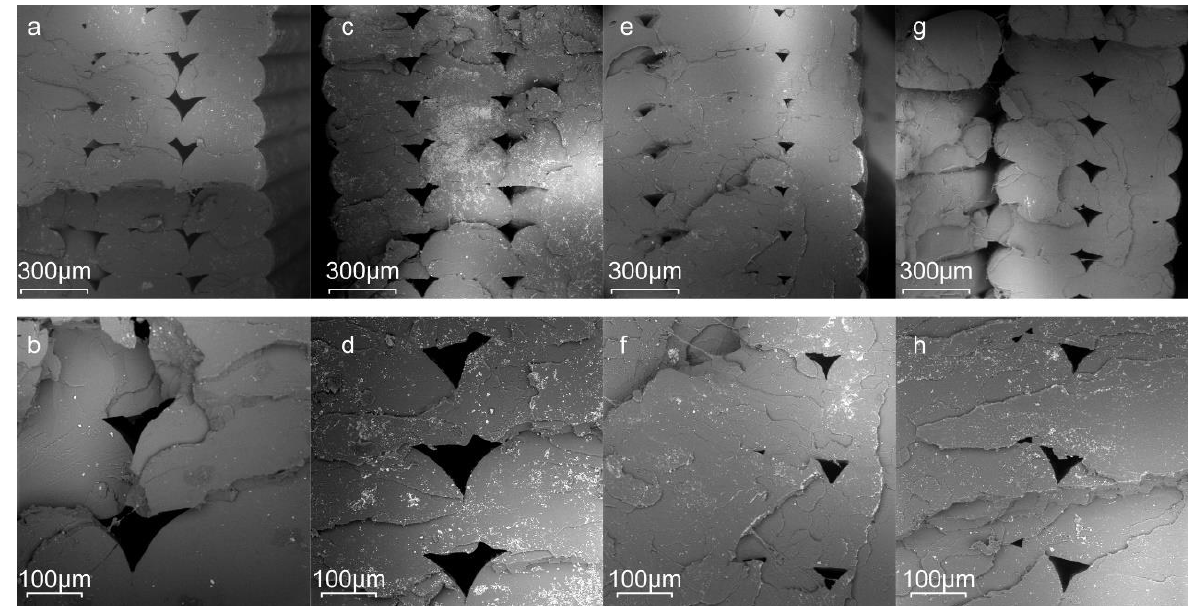
Figure 8. SEM microstructure of the cross section (outer shells) of tensile fracture surface at low and high magnifications for ( a , e ) PLA neat, ( b , f ) PLA/J1, ( c , g ) PLA/J2, and ( d , h ) PLA/J3 materials.